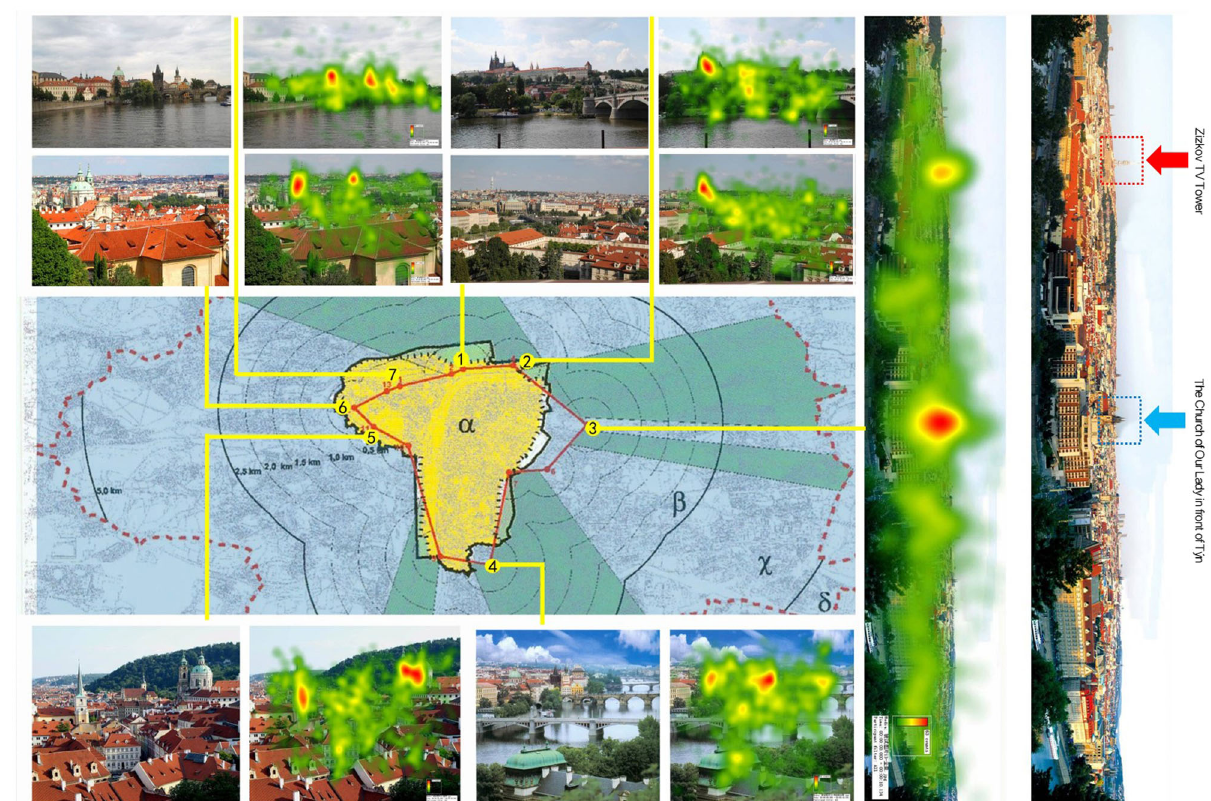
Fig. 6 Heatmaps were derived from eye-tracking studies at seven established points. Figure 7 displayed the winding streets in both Old Town and Malá Strana (Lesser Town), highlighted with a purple rectangle in Fig. 1. The diversity of street views was preserved in urban areas of Braque. Unlike urban squares, whose shapes and enclosing HUMANITIES AND SOCIAL SCIENCES COMMUNICATIONS| (2022) 9:400